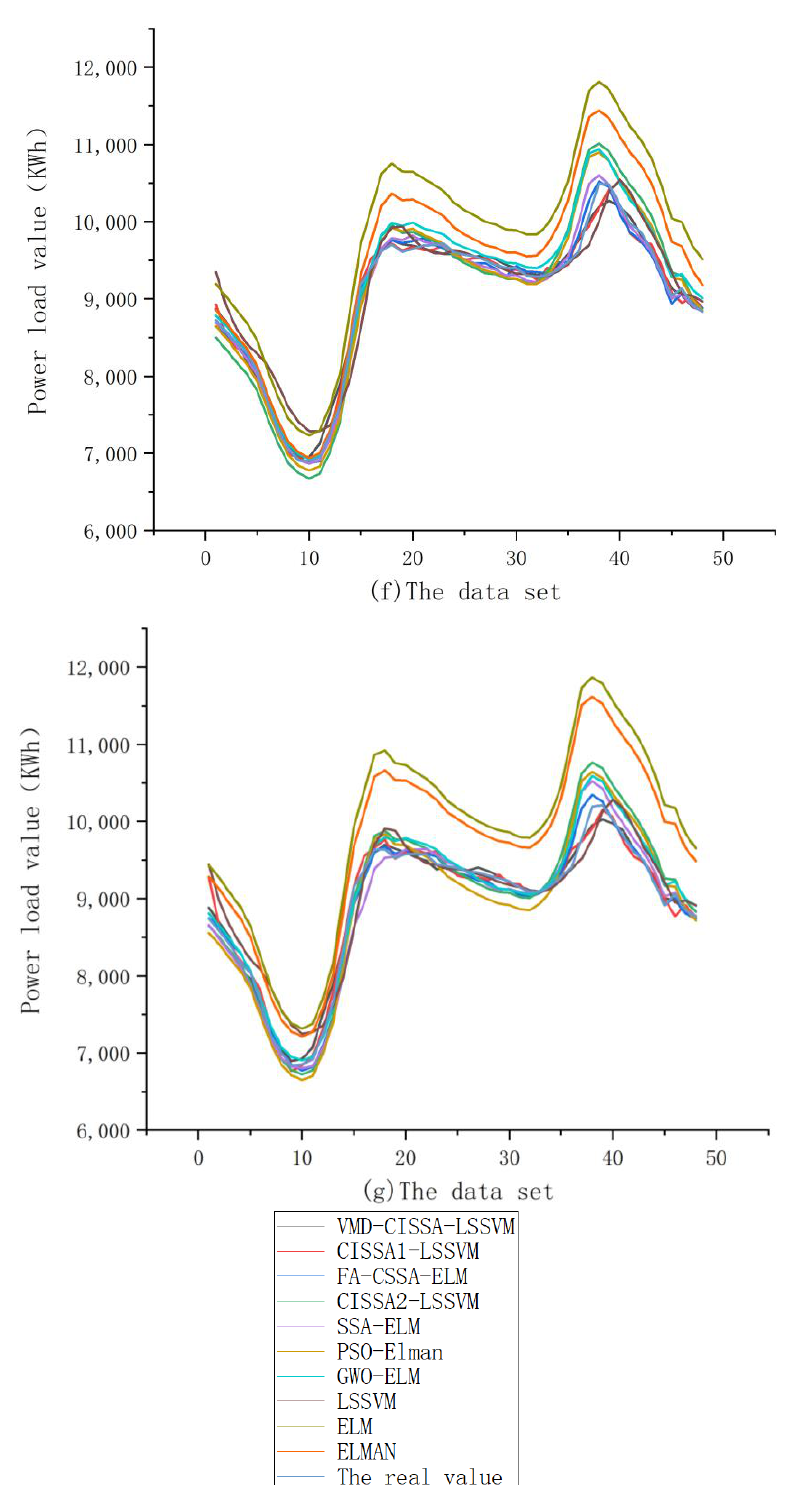
Figure A1. Final daily power load forecast values of different forecast models. ( a ) Prediction results of different prediction models in the Monday subset; ( b ) prediction results of different prediction models in the Tuesday subset; ( c ) prediction results of different prediction models in the Wednesday subset; ( d ) prediction results of different prediction models in the Thursday subset; ( e ) prediction results of different prediction models in the Friday subset; ( f ) prediction results of different prediction models in the Saturday subset; ( g ) prediction results of different prediction models in the Sunday subset.